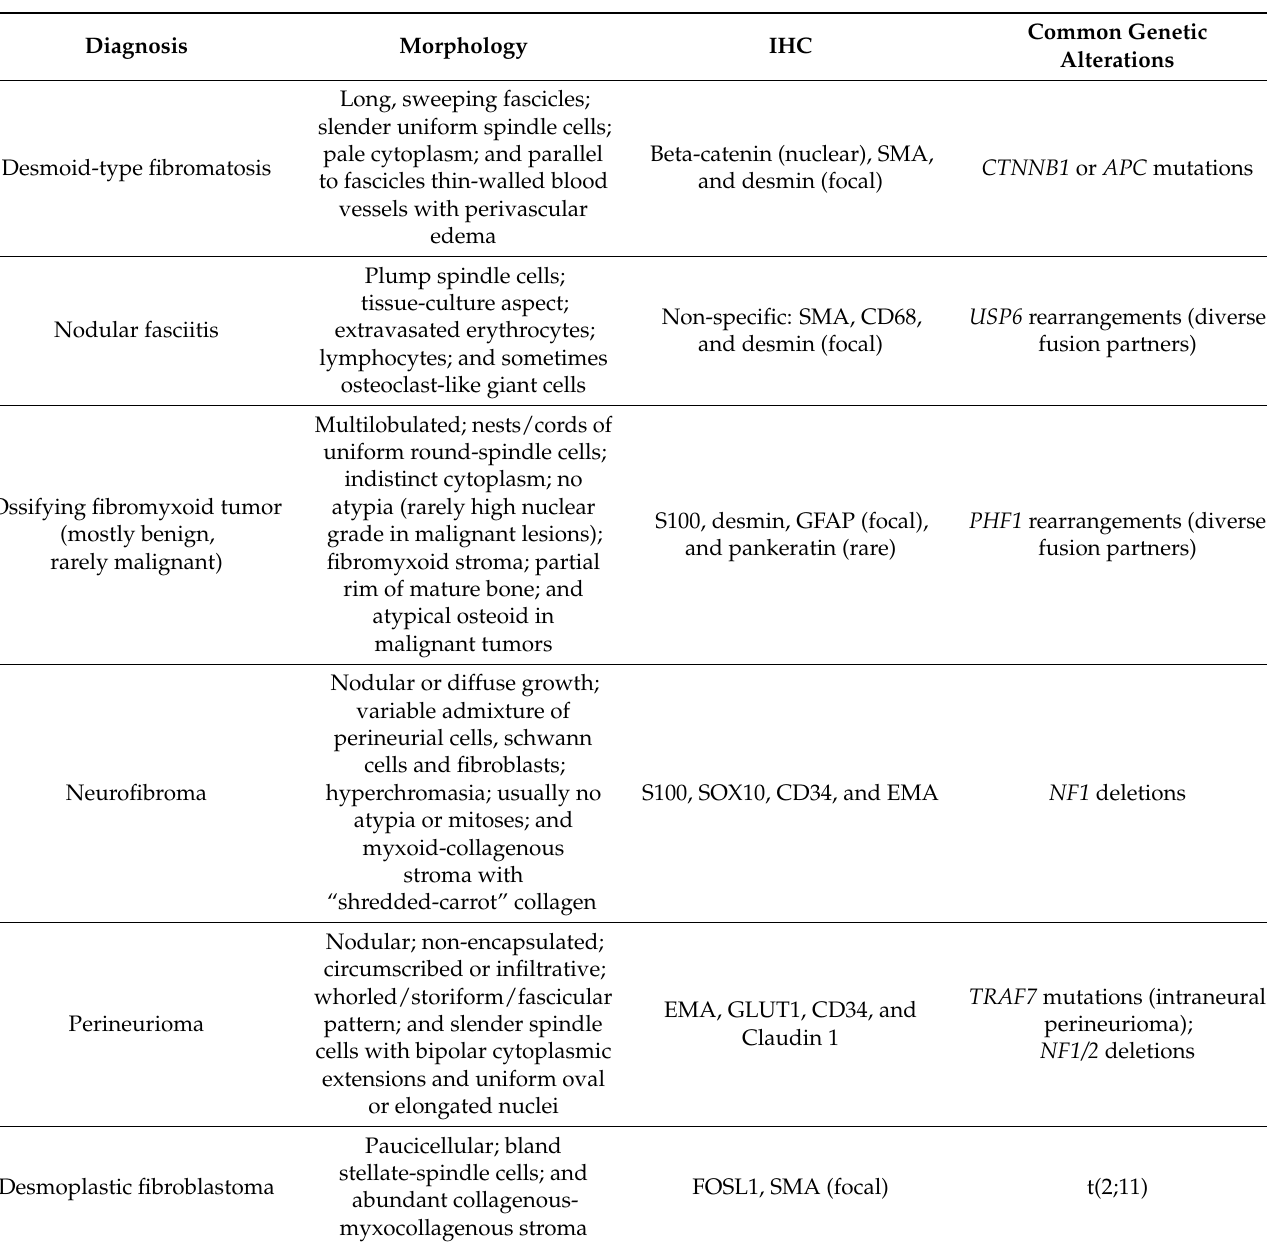
Table 10. Differential diagnoses of